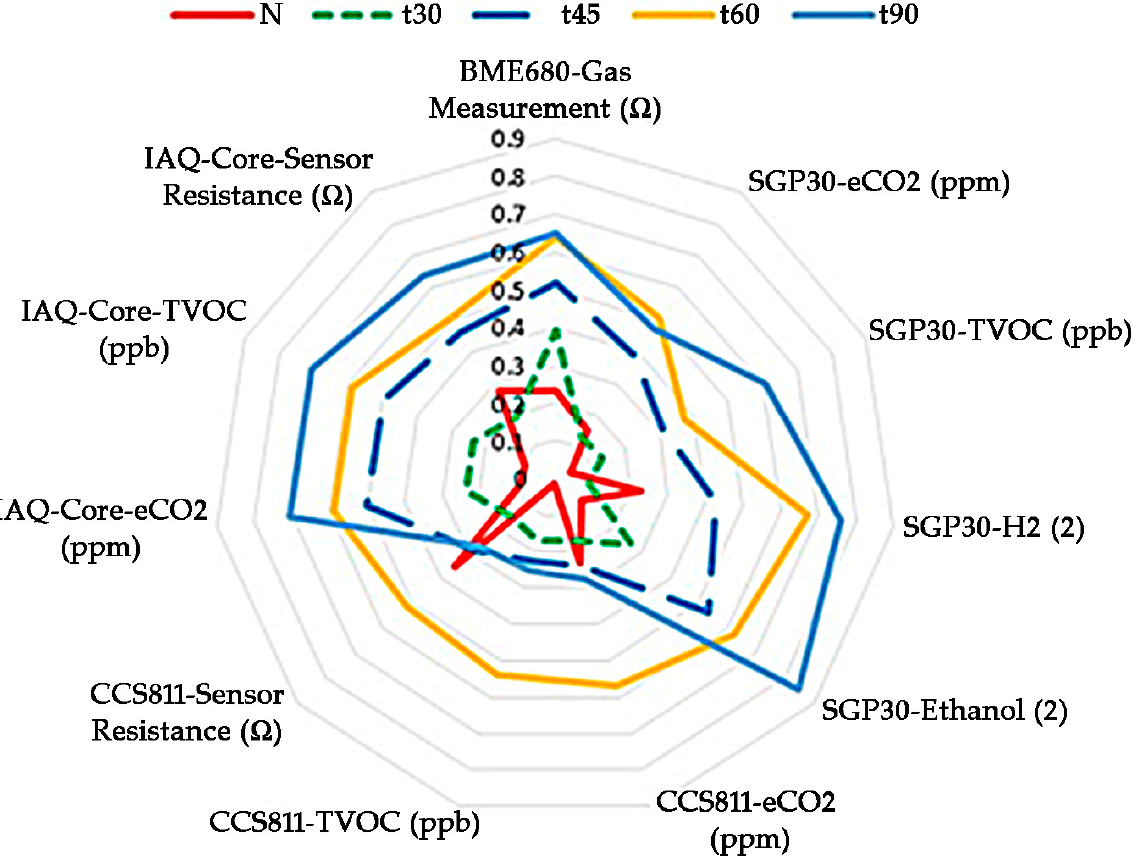
Figure 2. Radial plots of the sensors’ responses to different thermal treatments applied to fresh almonds before oil extraction.